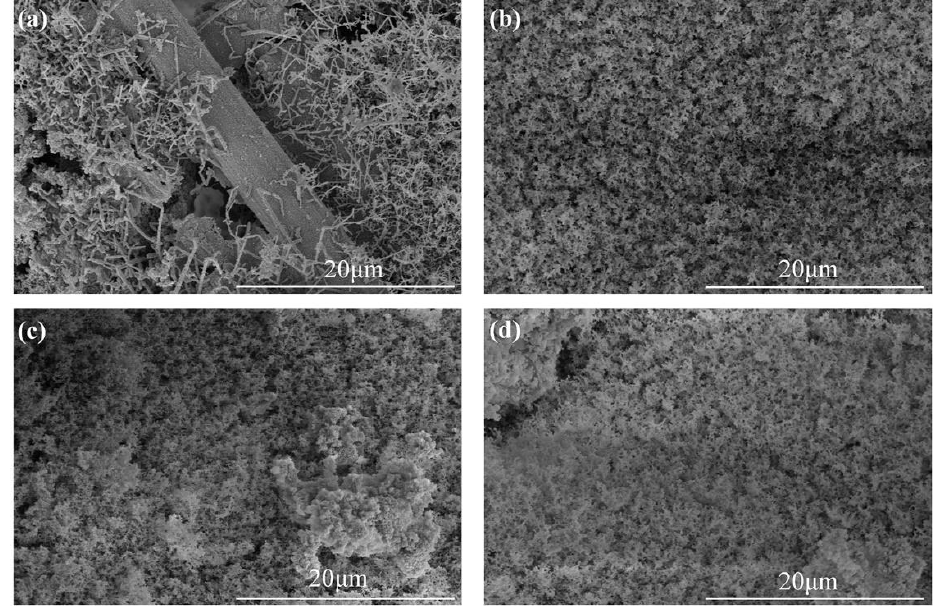
Figure 8. High magnification SEM images of ablated surfaces: ( a ) SF-0.5; ( b ) SF-1; ( c ) SF-3; ( d ) SF-6.